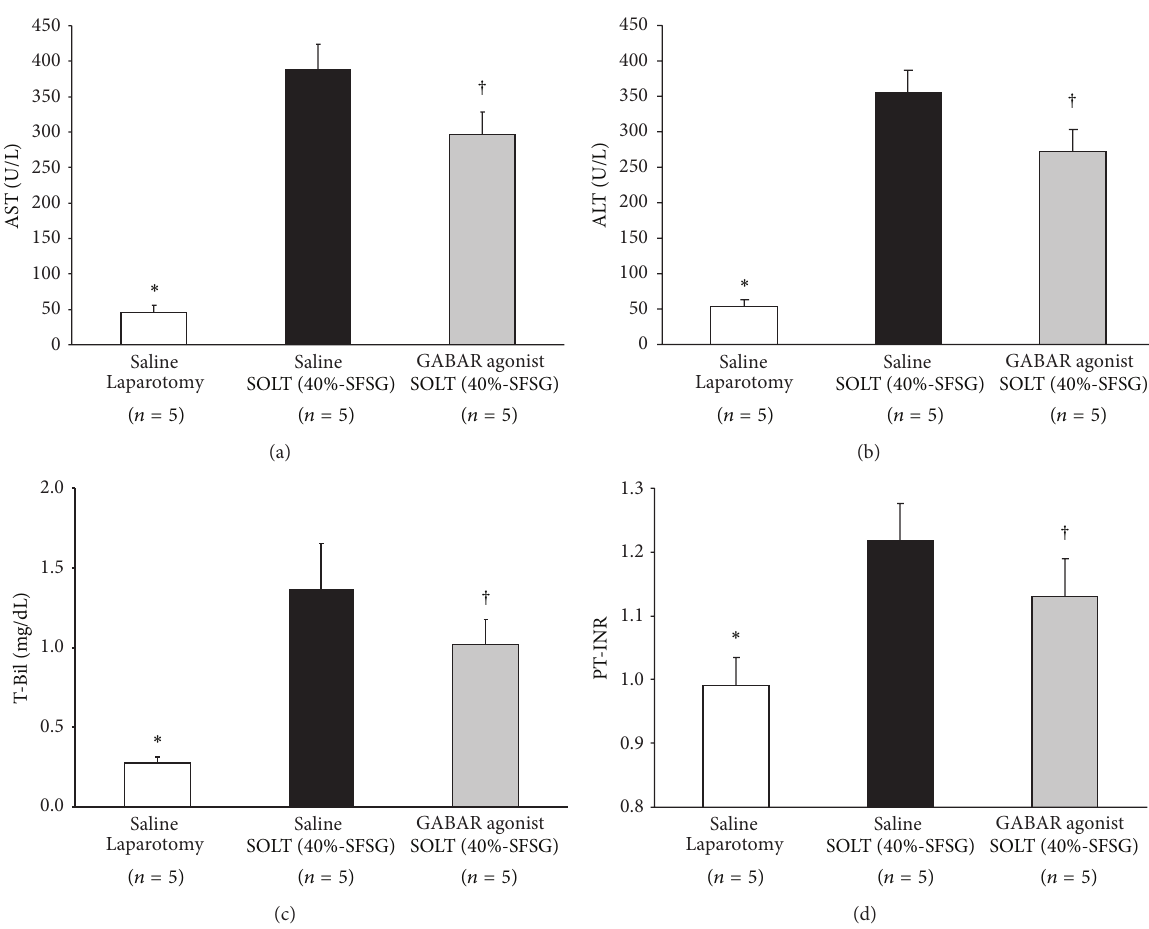
Figure 2: Biochemical and coagulation profiles. (a) AST levels. There were significant differences between laparotomy and SOLT with saline ( 𝑃 < 0.05 ∗ ) and between SOLT with saline and SOLT with GABAR agonist ( 𝑃 < 0.05 † ). (b) ALT levels. There were significant differences between laparotomy and SOLT with saline ( 𝑃 < 0.05 ∗ ) and between SOLT with saline and SOLT with GABAR agonist ( 𝑃 < 0.05 † ). (c) T-Bil levels. There were significant differences between laparotomy and SOLT with saline ( 𝑃 < 0.05 ∗ ) and between SOLT with saline and SOLT with GABAR agonist ( 𝑃 < 0.05 † ). (d) PT-INR. There were significant differences between laparotomy and SOLT with saline ( 𝑃 < 0.05 ∗ ) and between SOLT with saline and SOLT with GABAR agonist ( 𝑃 < 0.05† ). AST, aspartate aminotransferase; ALT, alanine aminotransferase; GABAR, 𝛾 -aminobutyric acid receptor; SFSG, small-for-size graft; SOLT, split orthotopic liver transplantation; PT-INR, international normalized ratio of prothrombin time; and T-Bil, total bilirubin. 1.22 ± 0.06 ; 𝑃 = 0.0001 ) and between SOLT with saline